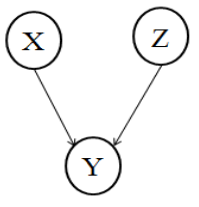
Figure 1. Illustration of a V-structure.